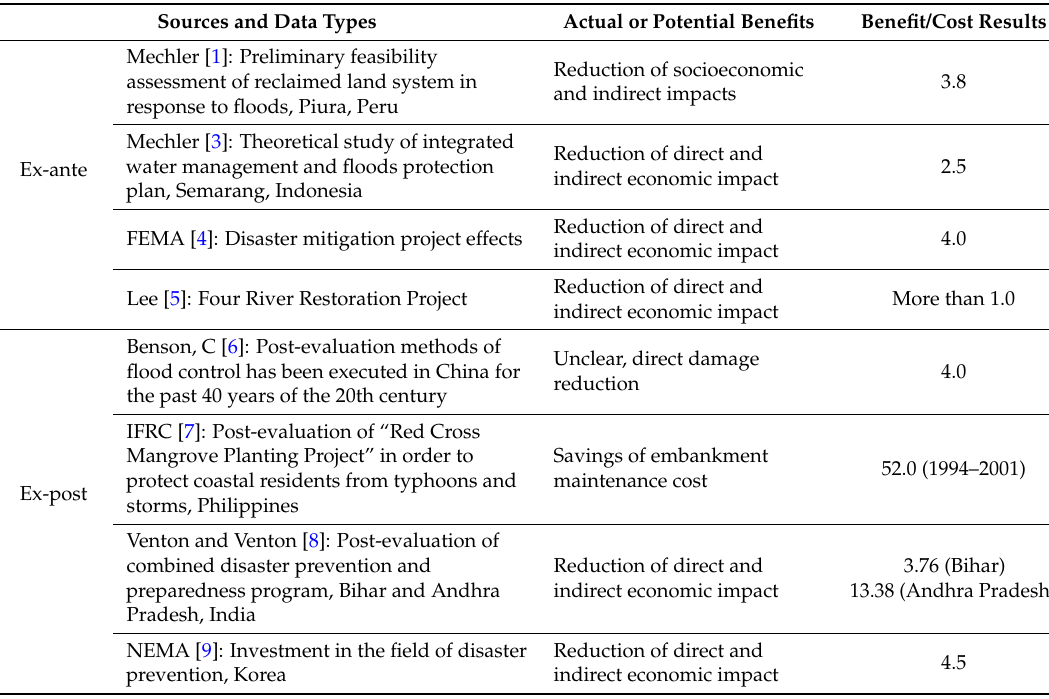
Table 1. Benefit/cost analysis of disaster prevention